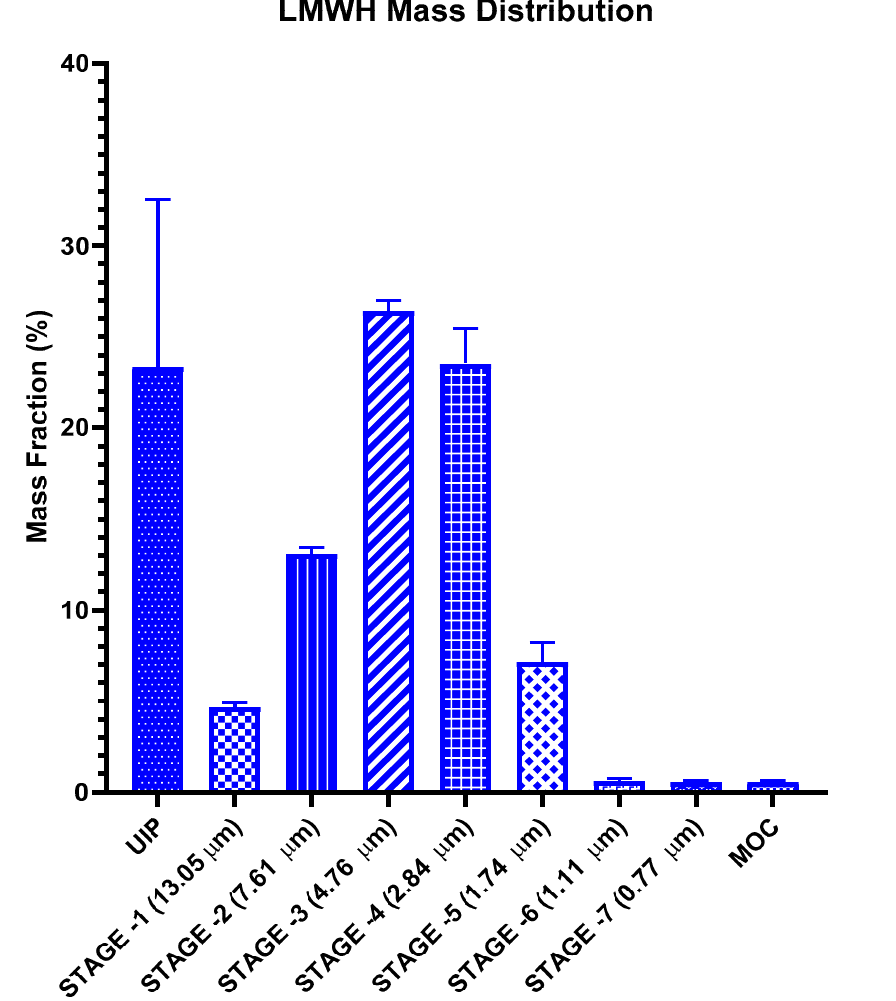
Figure 3. Lung deposition of LMWH solution in each of the NGI stages ( n = 6, p < 0.01).